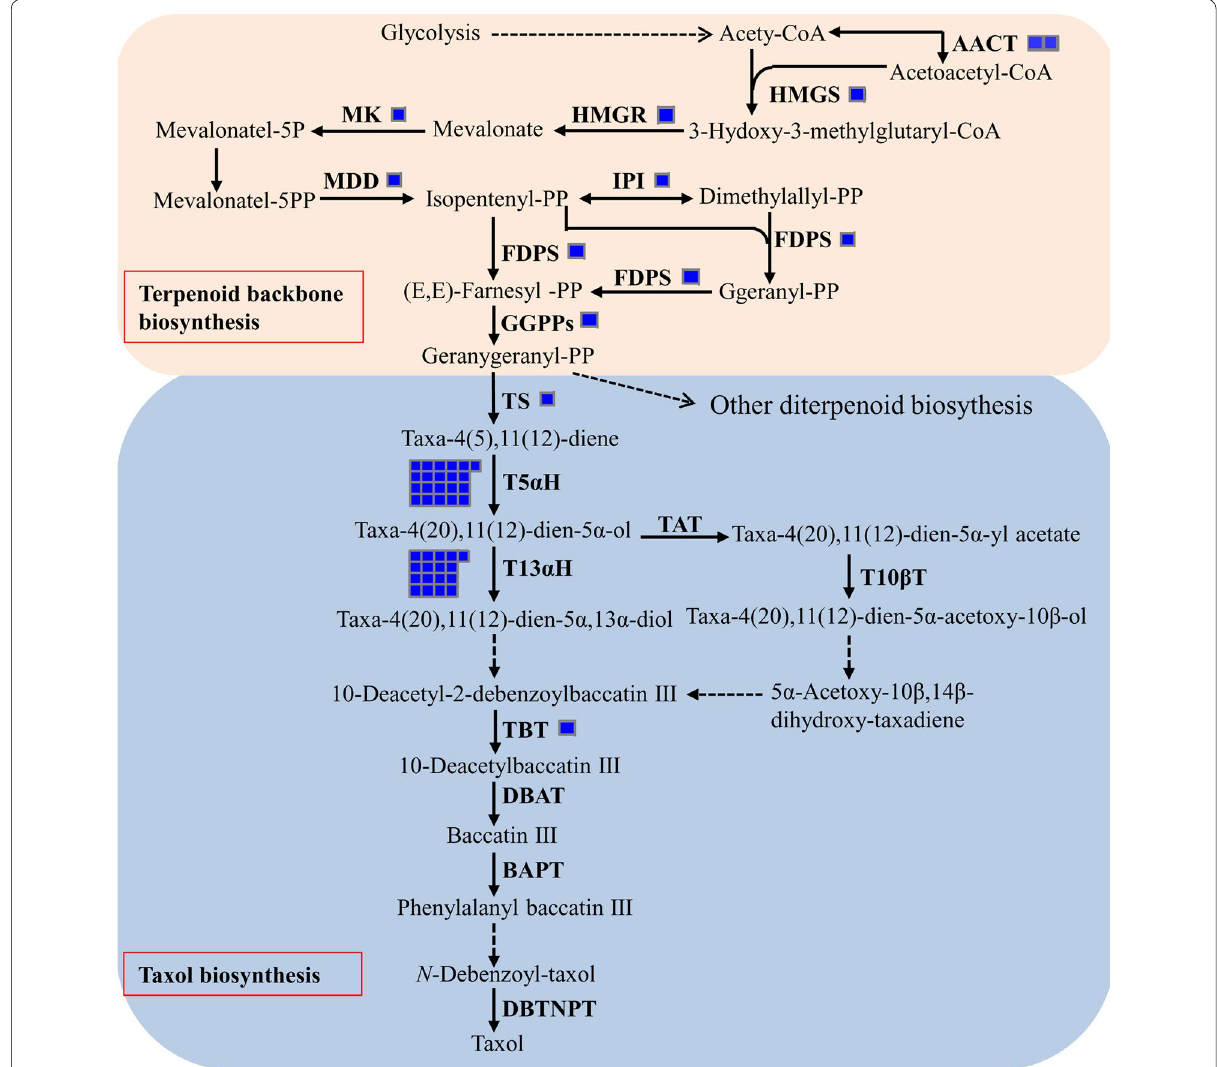
Fig. 5 Overview of the potential fungal taxol biosynthesis pathway of C. cladosporioides MD2. The numbers of genes in families with at least one gene were indicated by the numbers of blue rectangles. Identified enzymes included: AACT acetyl‑CoA C‑acetyltransferase, HMGS hydroxym‑ ethylglutaryl‑CoA synthase, HMGR hydroxymethylglutaryl‑CoA reductase, MK mevalonate kinase, MDD diphosphomevalonate decarboxylase, IPI isopentenyl‑diphosphate delta‑isomerase, FDPS farnesyl diphosphate synthaseisopentenyl‑diphosphate delta‑isomerase, GGPPs geranylgeranyl diphosphate synthaseisopentenyl‑diphosphate delta‑isomerase, TS taxadiene synthaseisopentenyl‑diphosphate delta‑isomerase, T5αH taxadiene 5‑alpha‑hydroxylaseisopentenyl‑diphosphate delta‑isomerase, T13αH taxane 13‑alpha‑hydroxylaseisopentenyl‑diphosphate delta‑isomerase, TBT 2‑alpha‑hydroxytaxane 2‑ O